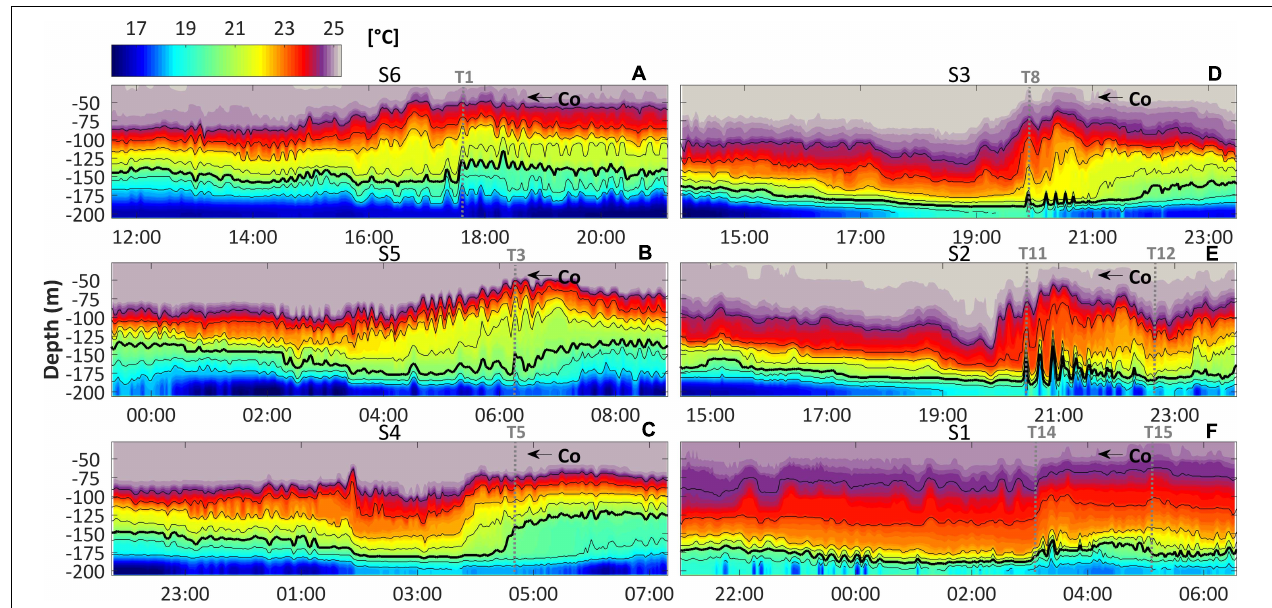
FIGURE 7 | (A–F) Welch’s power spectral densities (PSD) calculated for each relevant 2-day segment on PIL200 within a confidence interval of 95%. The fall-off rates are addressed from 1-h to the local buoyancy frequency ( N l ) and from N l to 4-min.